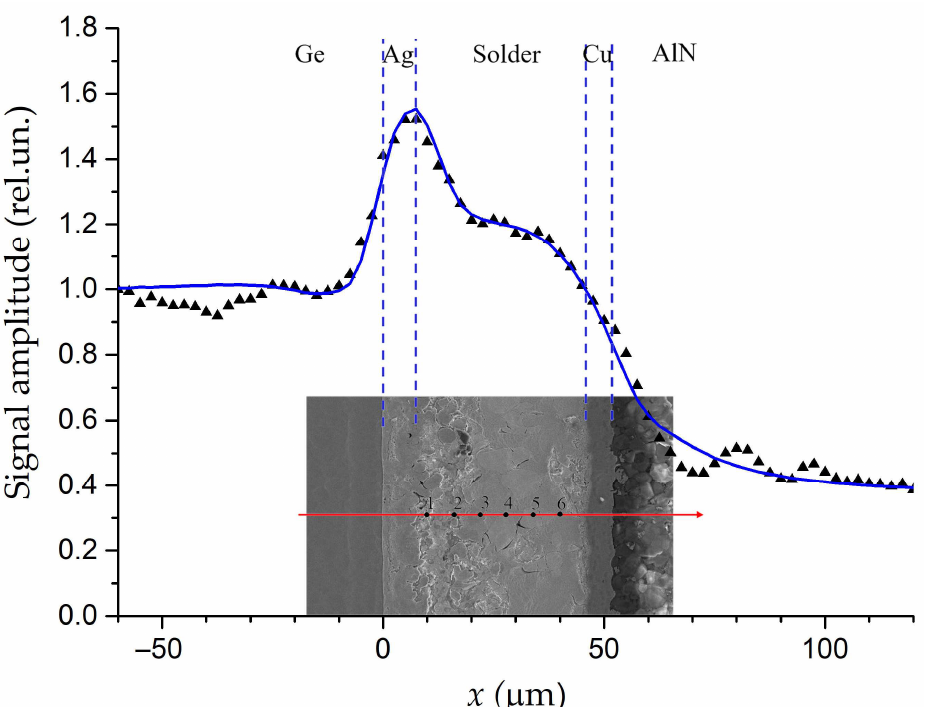
Figure 4. Calculated sensitivities to thermal conductivity, K , volumetric heat capacity, ρC , the inter- facial TR, r th , and the reactive thermal conductance, z th , for the sample in Figure 3. Dash lines are solder layer boundaries.